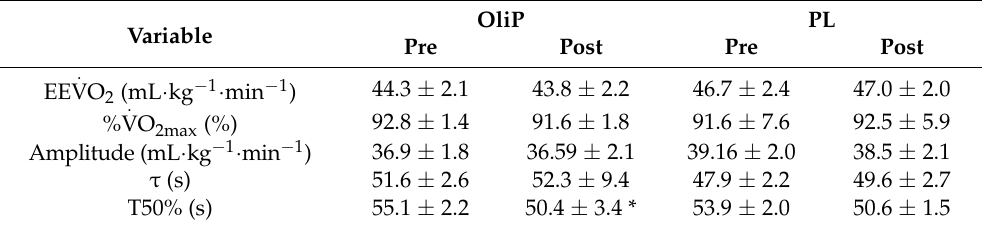
Figure 4. Recovery to T50% at pre- and post-intervention time points for the OliP and PL groups. * denotes significance between time points in the OliP group ( p = 0.026). Table 6. Recovery from submaximal exercise by intervention group (visit 3 and visit 5).